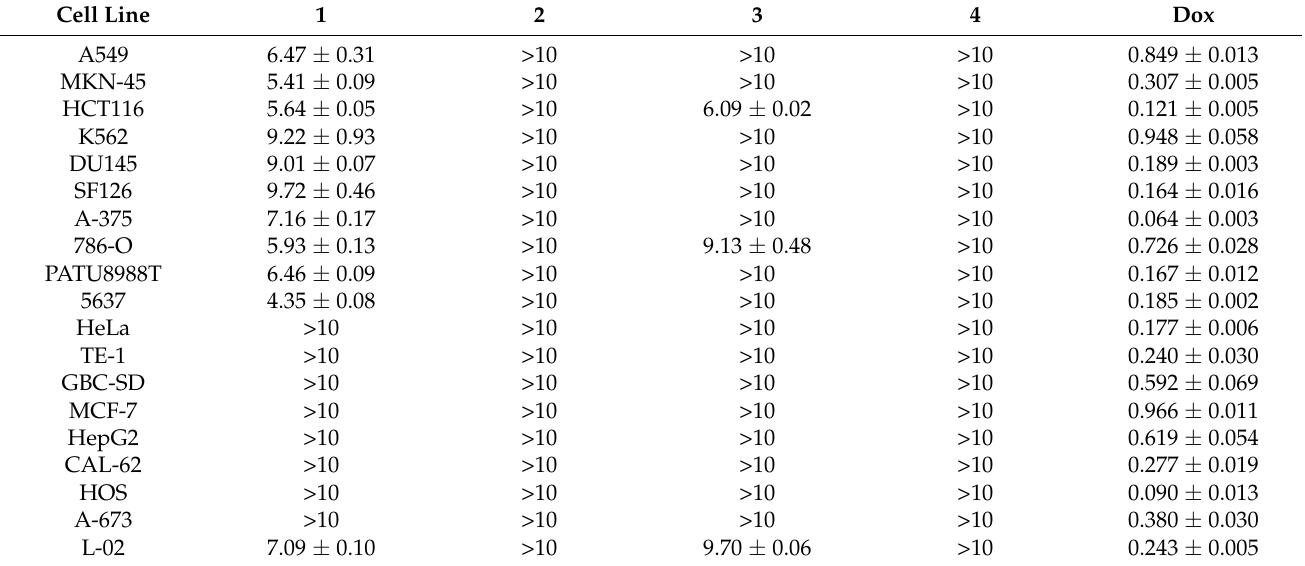
Table 3. Cytotoxic activity ( µ M, IC 50 ± SD), n =